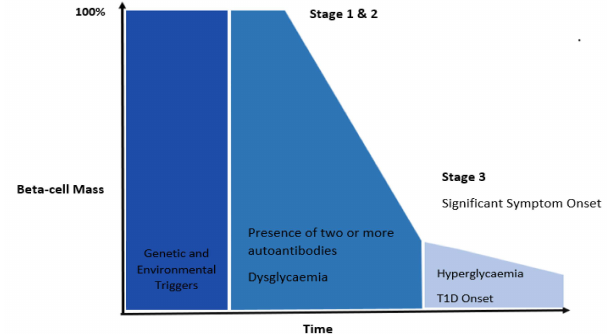
Figure 1. Stages of T1D according to classical theories. Genetic susceptibility and